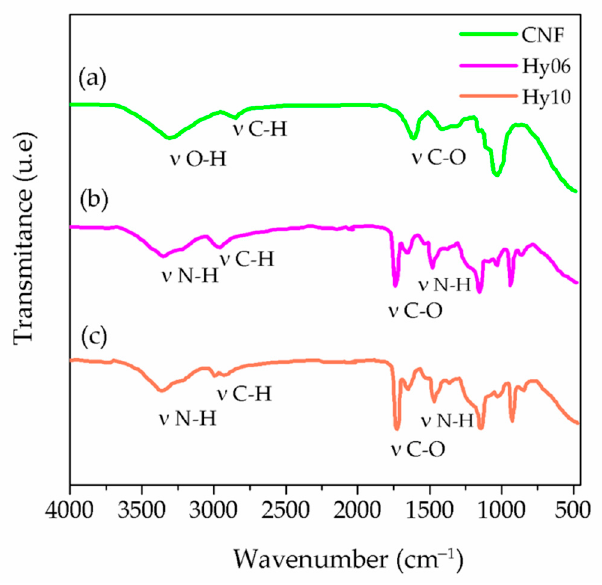
Figure 3. FTIR analysis of ( a ) CNF, ( b ) Hy06 (hydrogel without CNF), and ( c ) Hy10 (hydrogel with CNF).